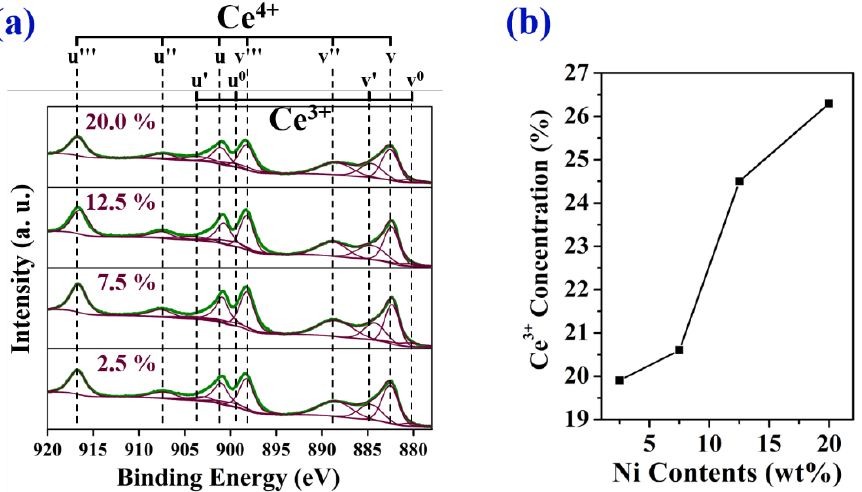
Figure 6. XPS spectra of Ce 3d in reduced Ni@CeO 2 catalysts prepared at different Ni-loadings (2.5, 7.5, 12.5, and 20 wt%) ( a ) and the concentration of Ce 3+ in reduced Ni@CeO 2 catalysts estimated by XPS analysis ( b ). XPS analysis ( b